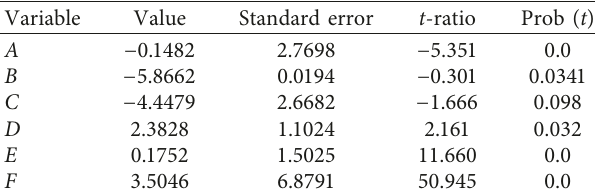
Table 5: Regression